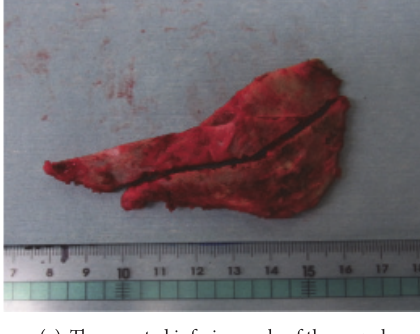
Figure 4: Intraoperative